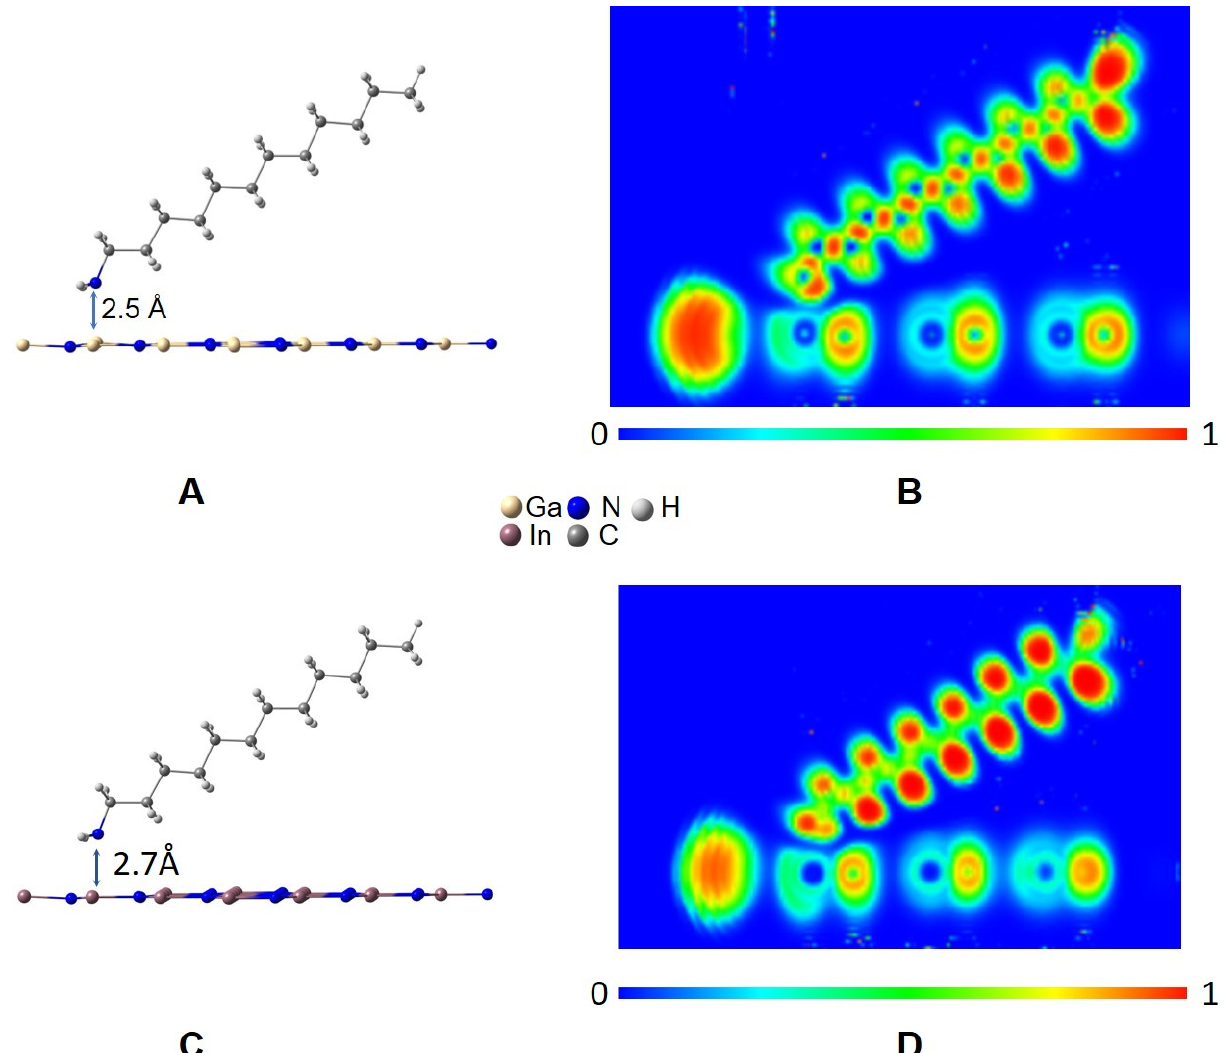
Figure 4. Optimized structures and ELF analysis for GaN-DDA ( A , B ) and InN-DDA ( C , D ) systems.